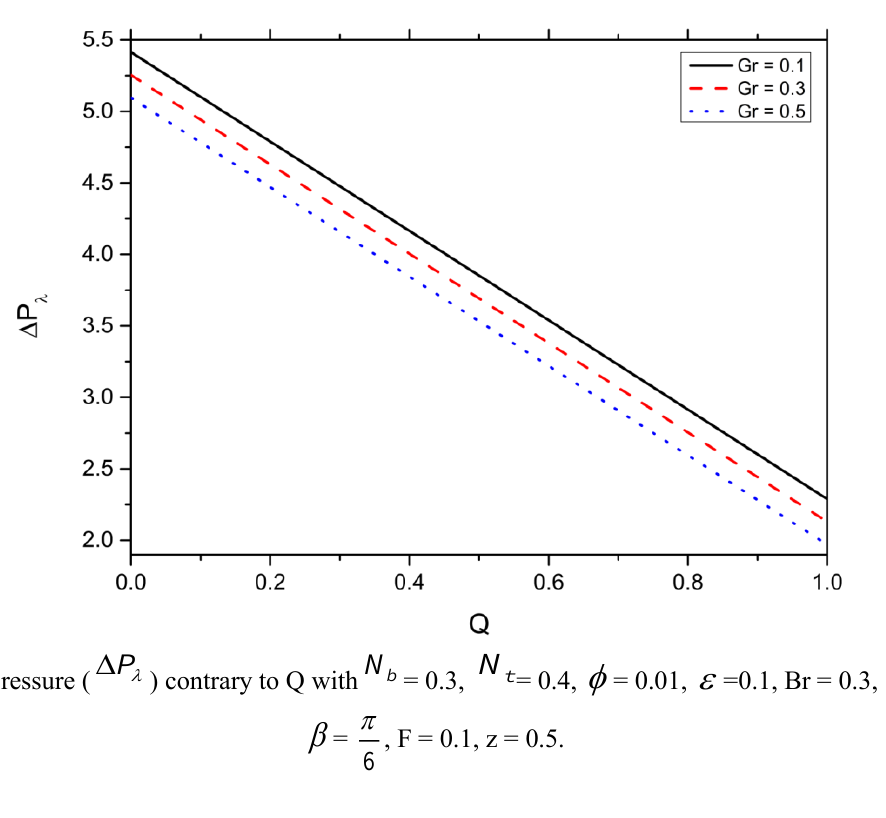
Fig. 2(a). Pressure (